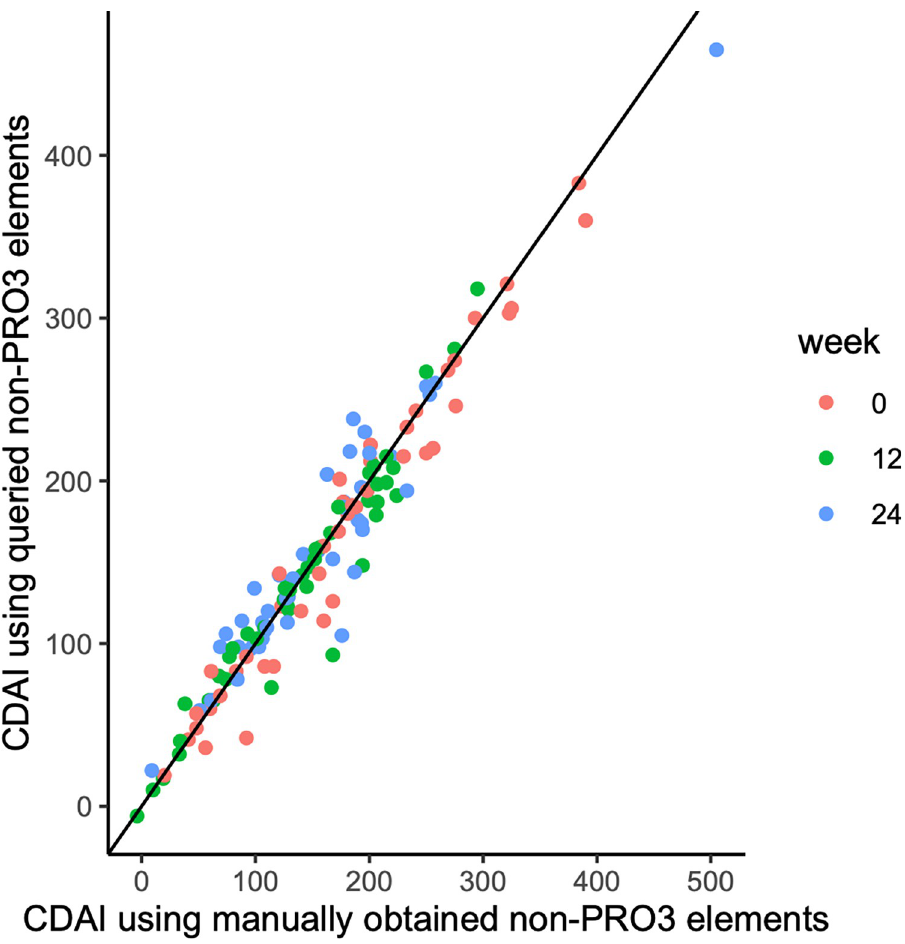
Fig 3. Comparison of total CDAI as computed using CDAI elements ascertained informatically vs manually. The y-axis corresponds to the CDAI calculated by database query of non-PRO3 elements. The x-axis corresponds to the CDAI calculated by manual abstraction.